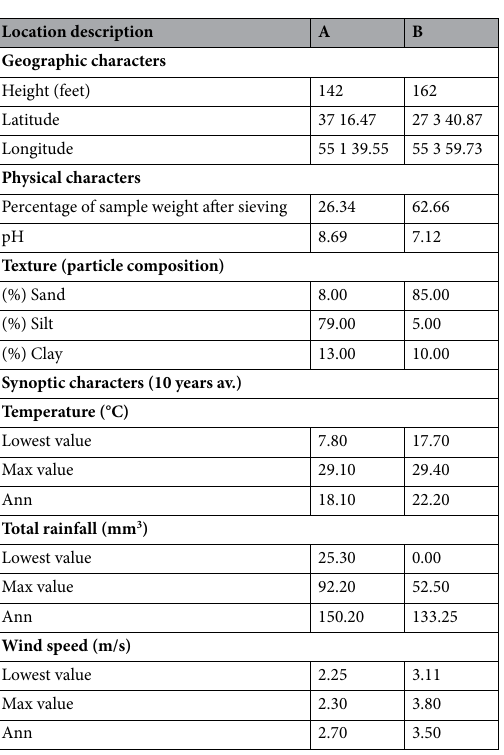
Table 1. Selected geographic and eco-physiological characters of soil samples along with two coastal deserts A and B from 2009 to